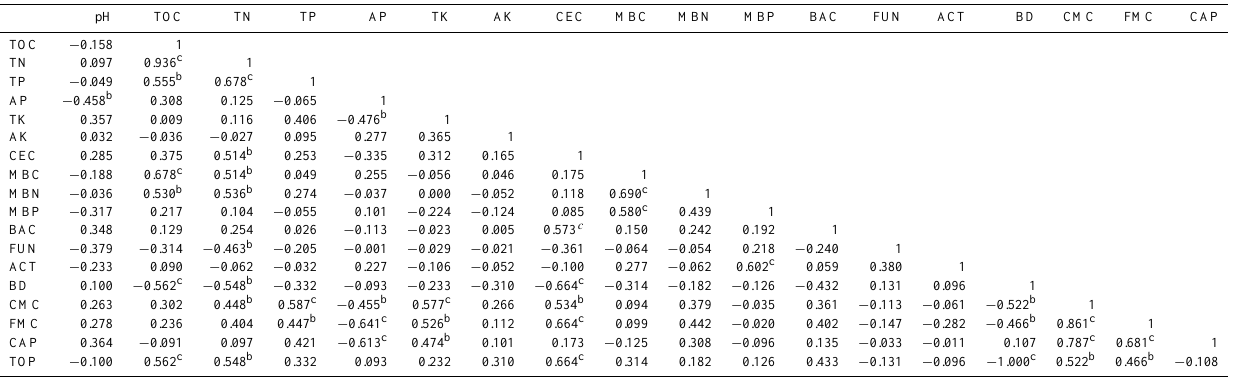
Table 3. Correlation matrix of soil evaluating indicators for rocky desertification a